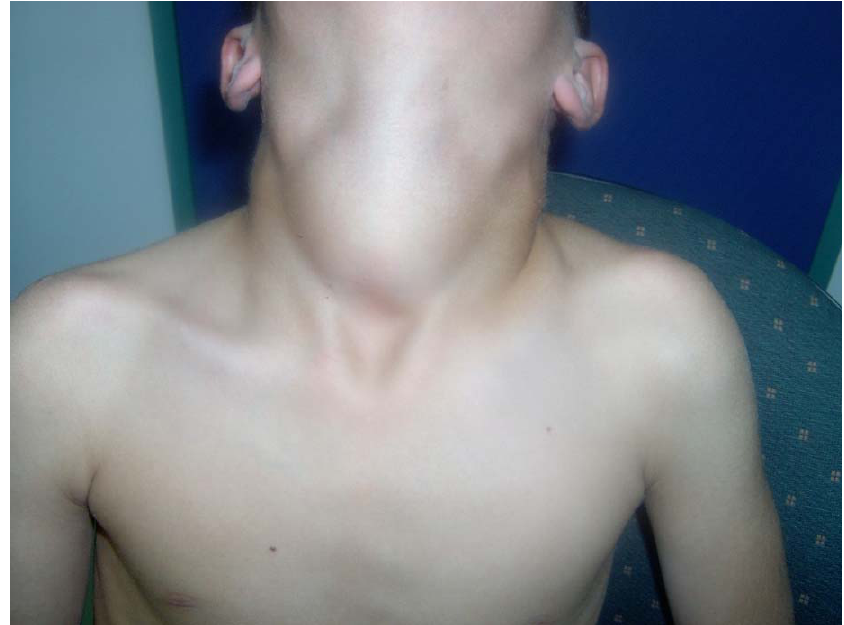
Figure 1. Massive MNG in a 15-year-old male with TPO mutation. (Written informed consent was obtained from the patient for publication of this case